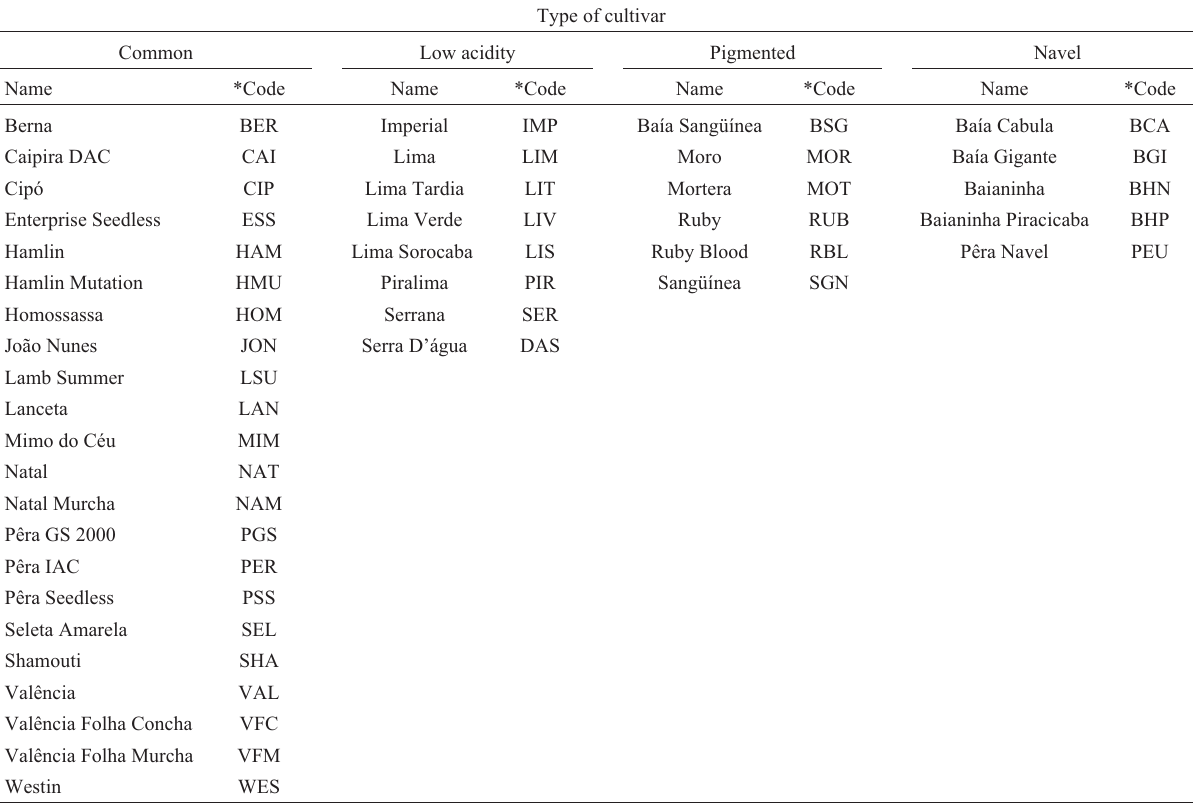
Table 1 - Sweet orange cultivars used in this